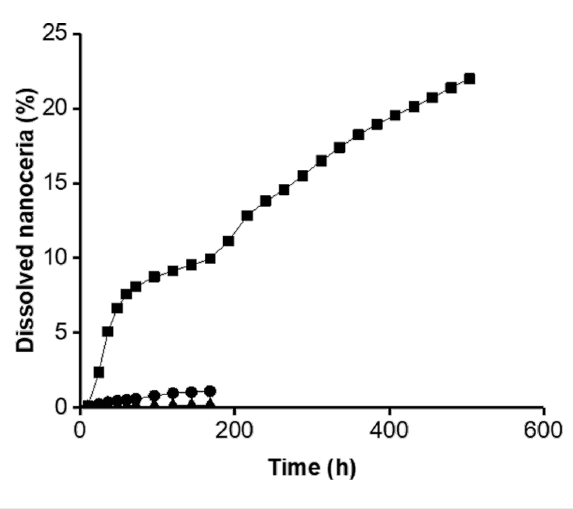
Figure 7: Dissolution of NM-211 (circles), NM-212 (triangles), and the solvothermally synthesized nanoceria (squares) determined in a single experiment using the continuous flow